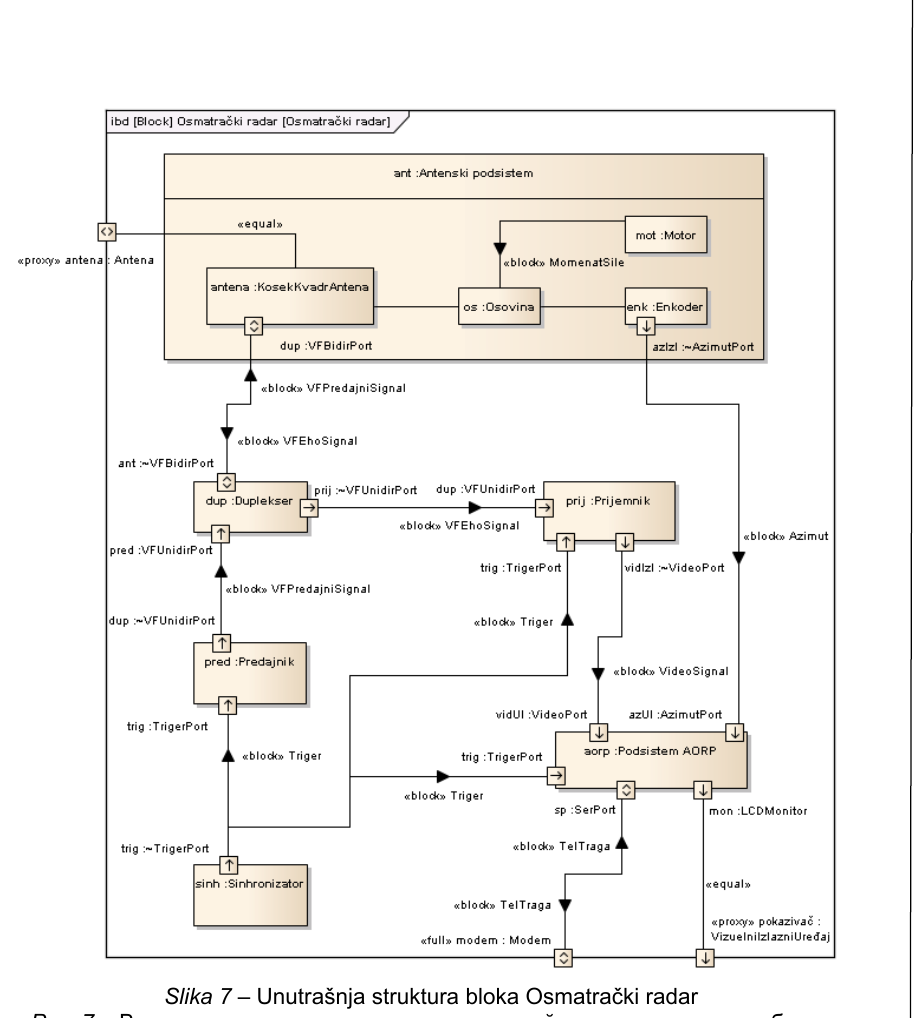
Рис . 7 – Внутренняя структура радиолокационной станции кругового обзора Figure 7 – Osmatra č ki radar (surveillance radar) block internal structure Parametarski dijagram specificira kako se ograni č avaju ć i blokovi koriste da ograni č e svojstva nekog bloka. Pod tim se podrazumeva povezivanje parametara ograni č avaju ć ih blokova sa specifi č nim svojstvima datog bloka, pomo ć u vezivnih konektora. Sude ć i po nekoliko primera parametarskih dijagrama iz (OMG, 2012), klju č na re č «equal» može se izostaviti sa ovih konektora. Na slici 9 definisani su osnovni elementi jednostavnog analiti č kog modela. U pitanju je jedan deo modela performansi osmatra č kog radara koji se odnosi na analizu maksimalnog dometa otkrivanja pokretnih objekata. Kod ograni č avaju ć ih blokova ograni č enja se svrstavaju u standardni odeljak constraints , a